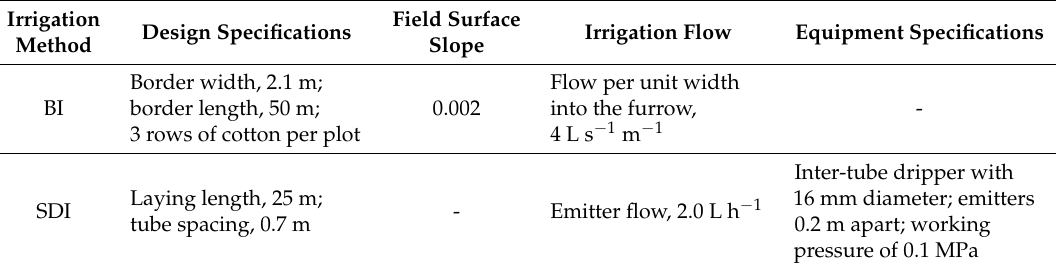
Figure 3. Layout of experimental plots (Unit: m). Table 3. Technical parameters of the different irrigation methods. Abbreviations: BI, border irrigation; and SDI, surface drip irrigation.